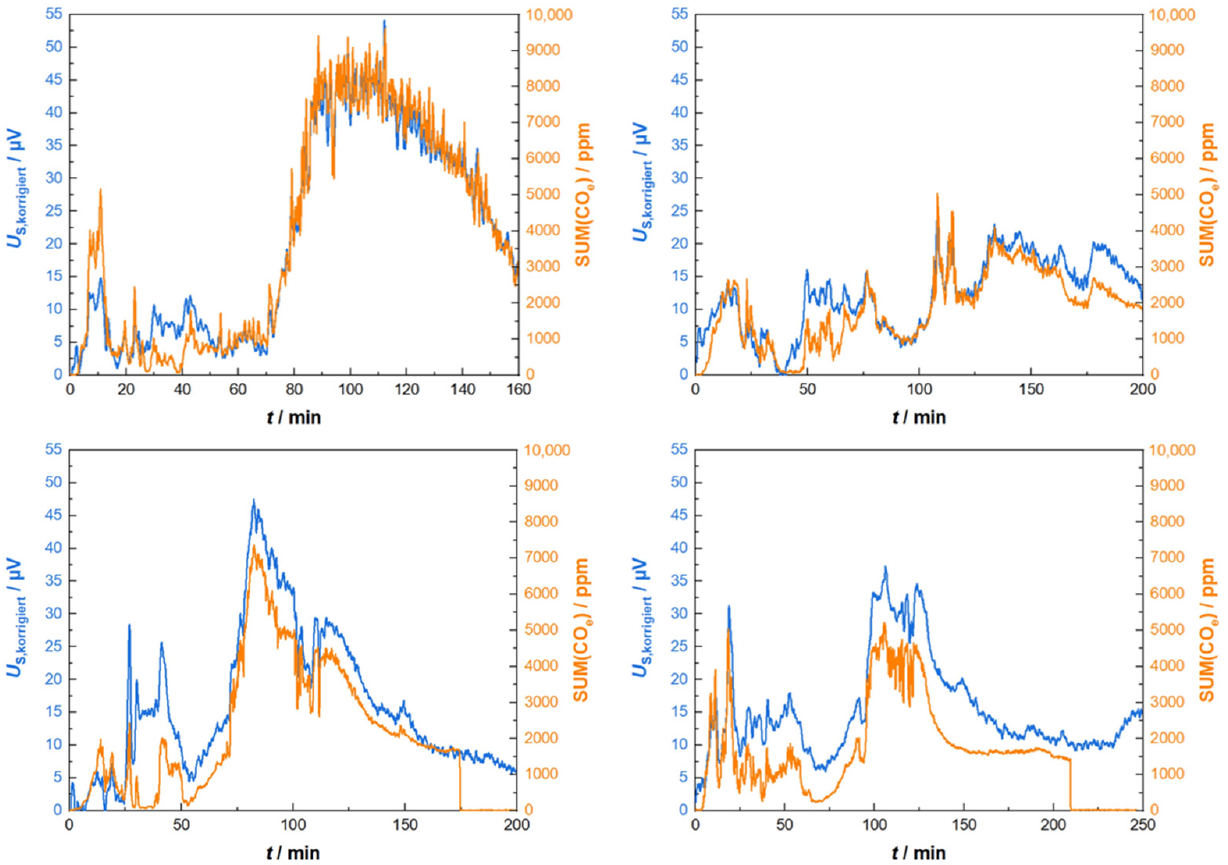
Figure 8. Corrected sensor signal (sensor type Gen_1) in comparison to analytic data for four different firing experiments. All raw signals were corrected with the same set of parameters as those described in the text and applied in the data in Figure 7.